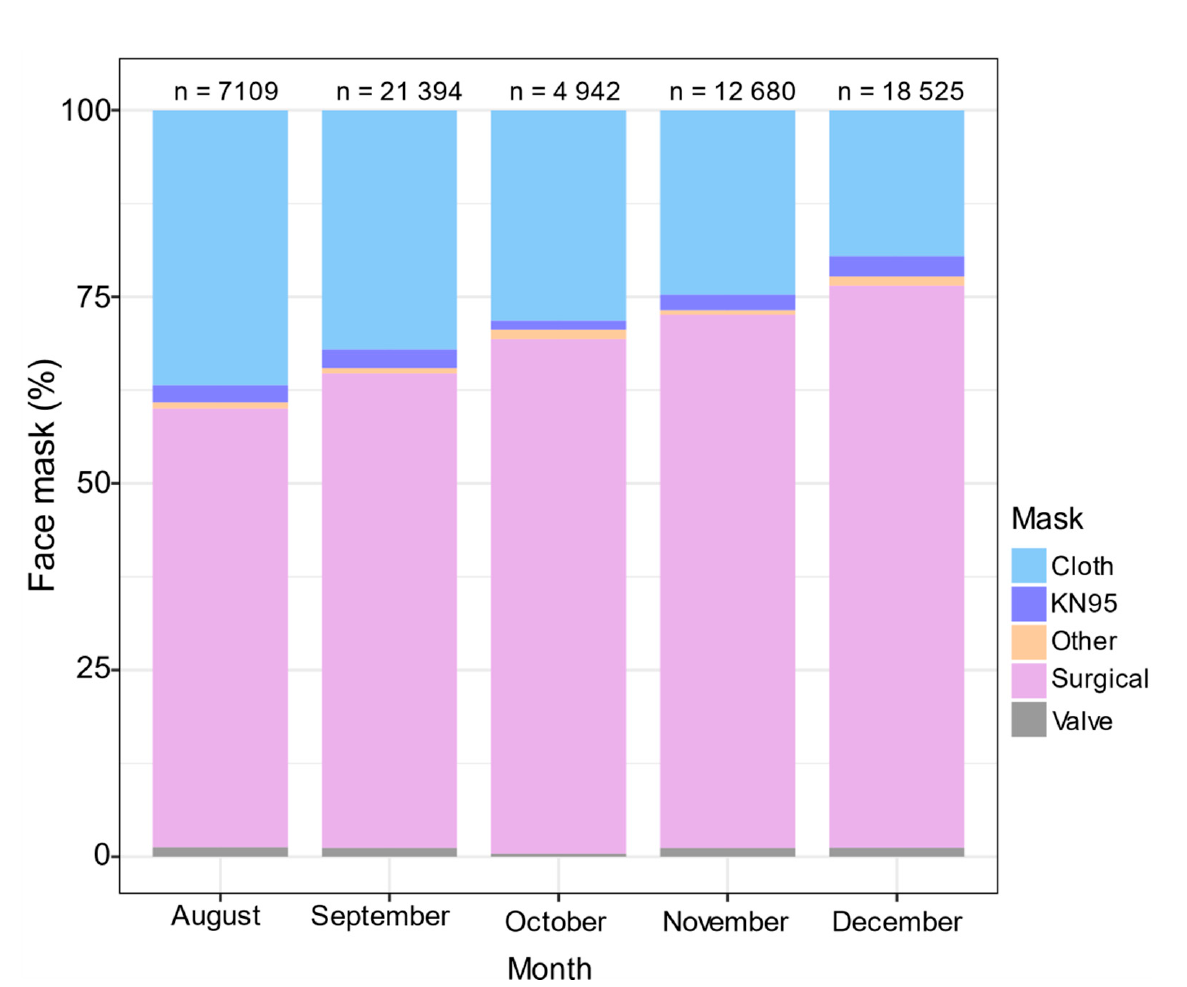
Figure 3. Usages of different types of face mask protection during the COVID-19 pandemic. Percentage of people wearing different types of masks in public areas between August and December 2020. A total of 64,650 observations were documented.